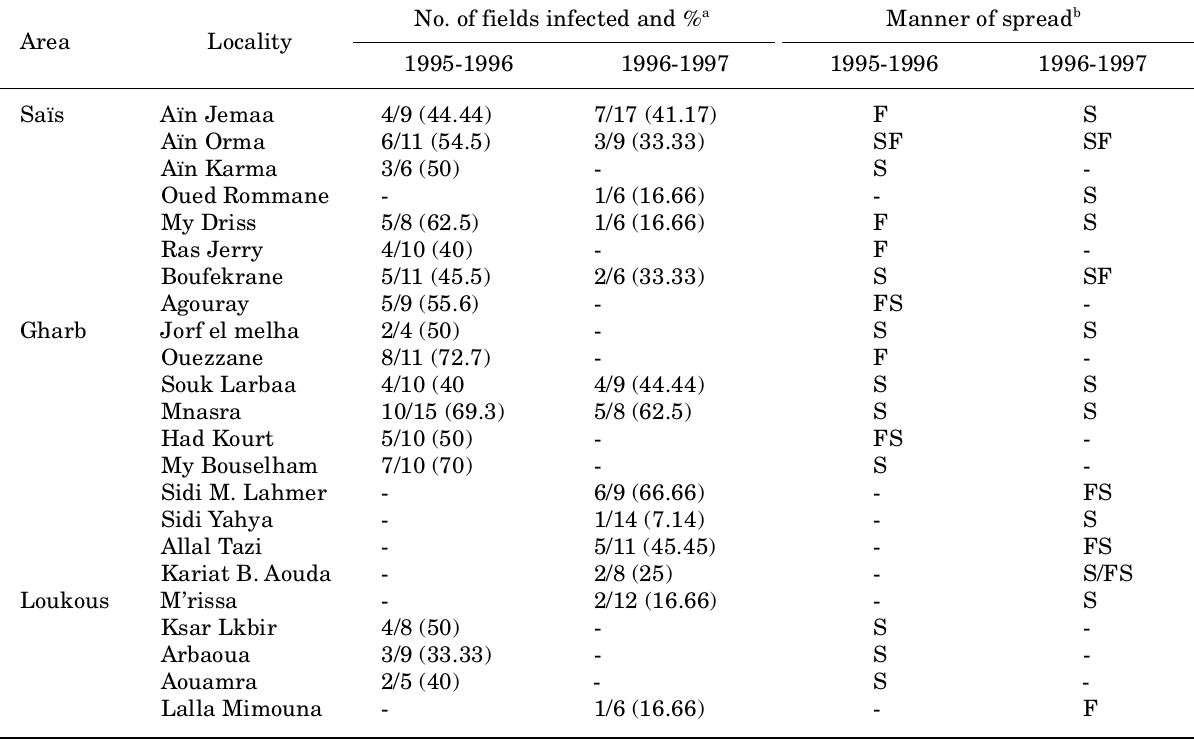
Table 2. Field incidence and manner of spread of downy mildew ( P. halstedii ) in the locations surveyed. No. of fields infected and % a